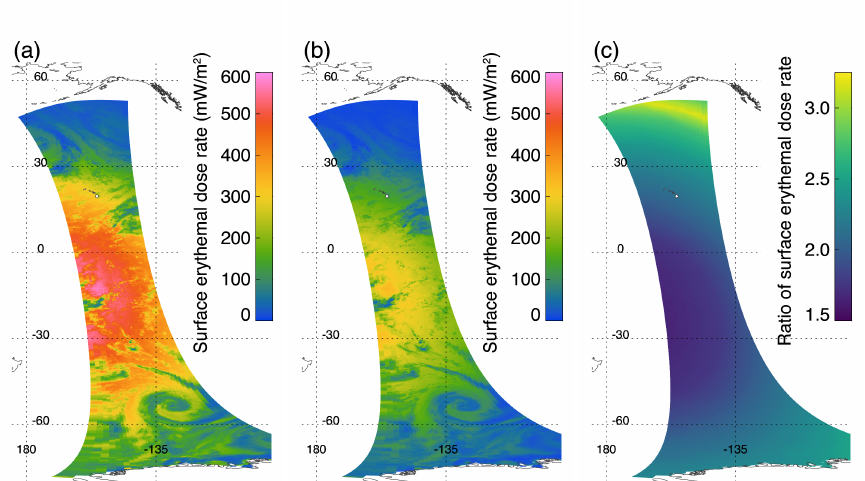
Figure 7. Maps of the surface erythemal dose rates: ( a ) calculated using the scalar irradiance; ( b ) calculated using the planar irradiance; ( c ) ratio of the scalar erythemal dose rate to the planar dose rate.